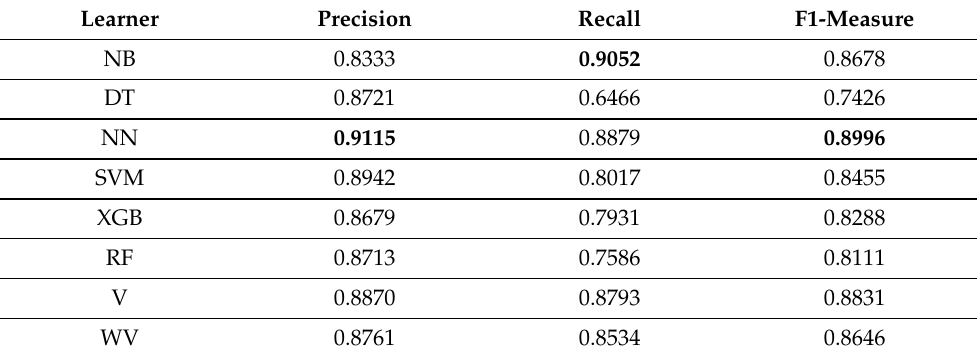
Table 6. Results on manually labeled gold standard, using both tweet and user features. The best results are marked in bold.